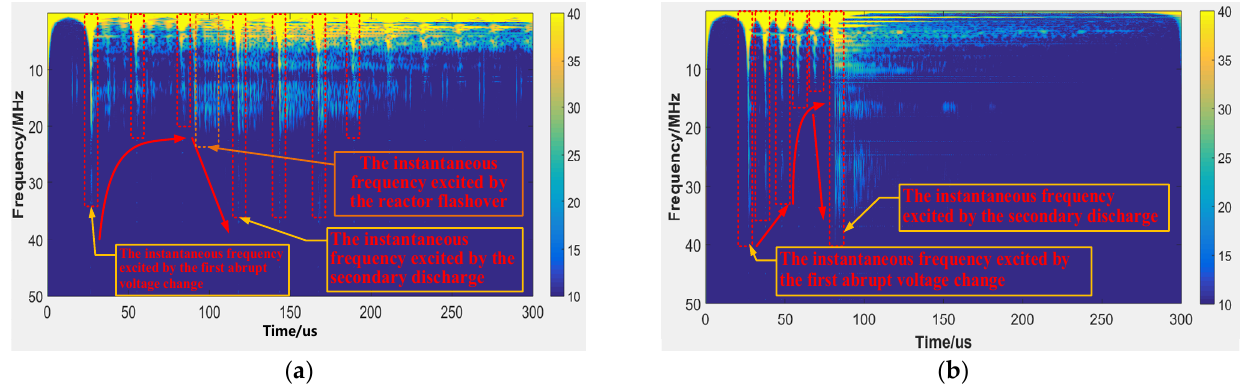
Figure 8. Time–frequency distributions of the transient voltage excited by SF 6 gap breakdown during dielectric withstand voltage test. ( a ) Spectrum measured by sensor A (south); ( b ) spectrum measured by sensor B (north).